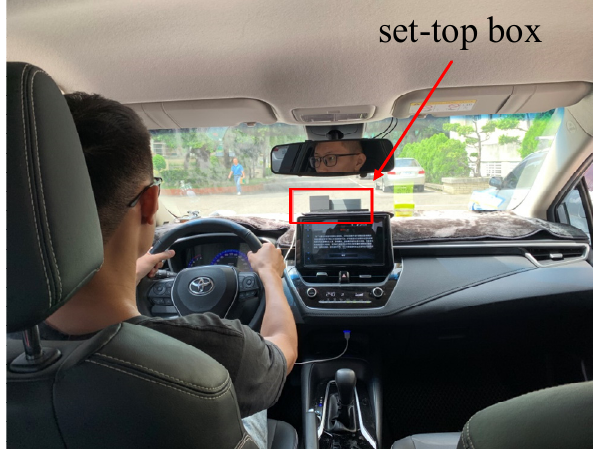
Figure 19. STB and its placement in a vehicle.